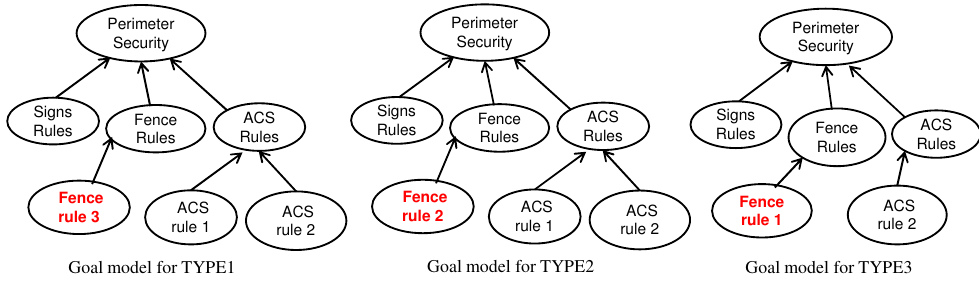
Figure 1. Goal model family of